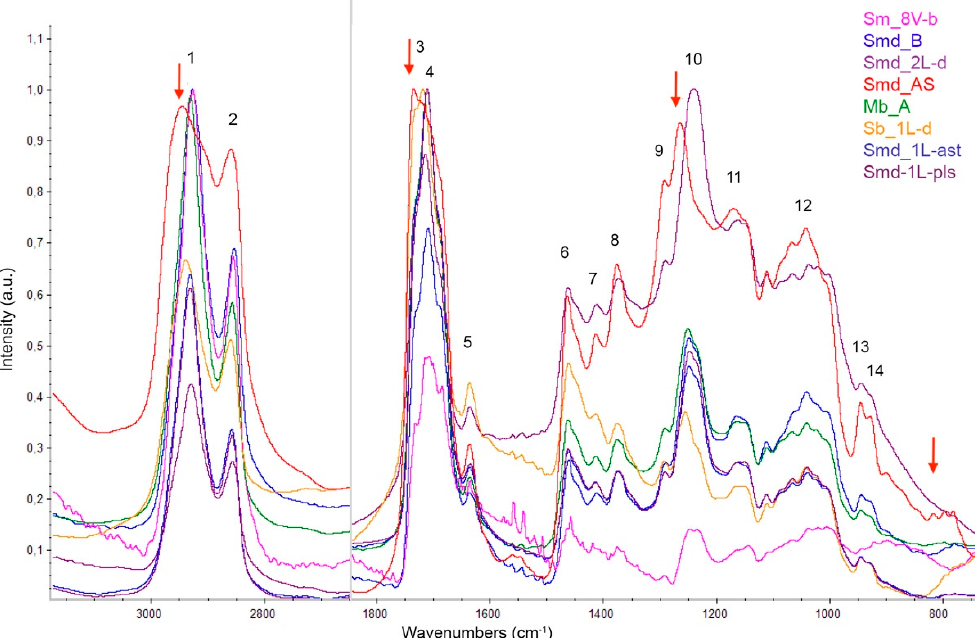
Figure 8. Difference between sample Smd_AS and the other shellac samples analyzed (red arrows). The number of top of the peaks (1 − 14) refers to peak assignments reported in Table 4. Table 4. Characteristic peaks of shellac. Peak assignment after [27,28].